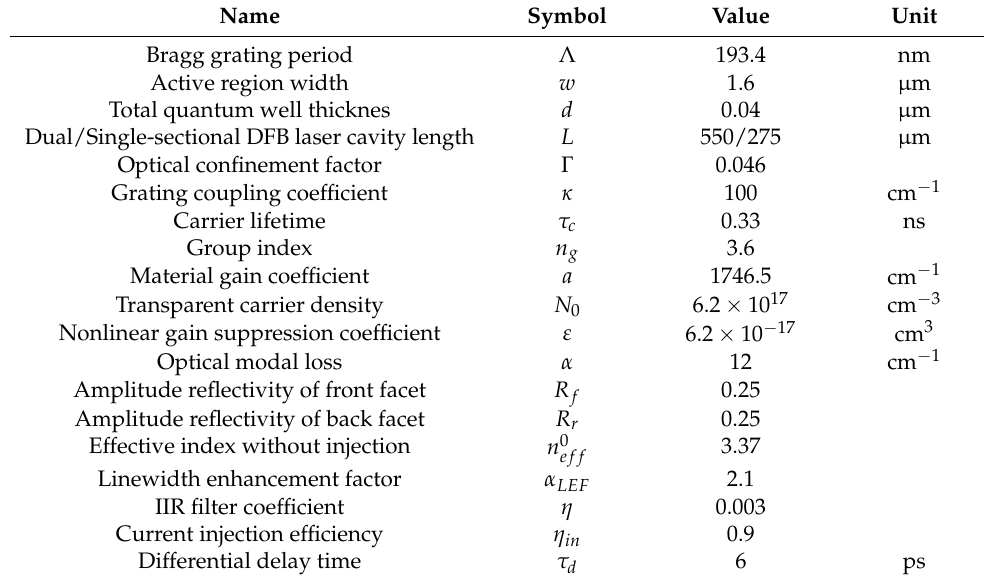
Table 3. Optimized parameters of the DFB laser.